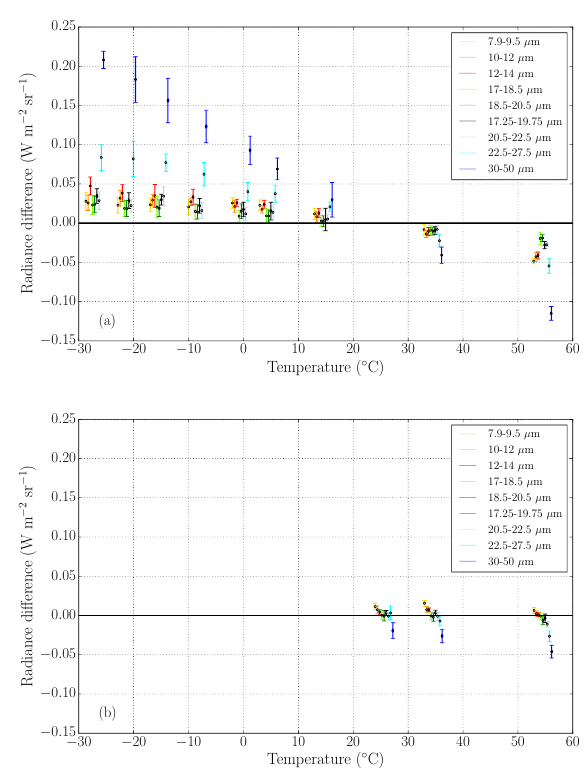
Figure 9. (a) Difference between NBB radiance retrieved with the FIRR algorithm and theoretical radiance for all NBB temperature steps. The error bars show the standard deviation for a given step. Panel (b) depicts the same as (a) but for ZBB